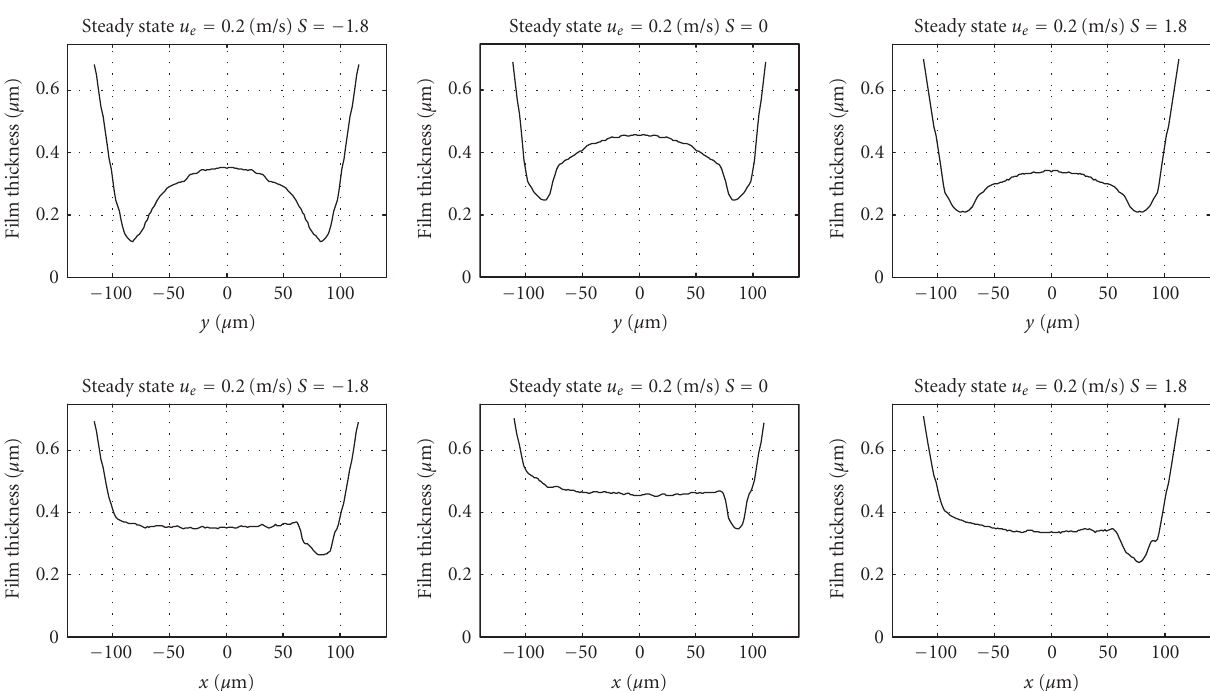
Figure 13: Film thickness profiles along the y - (top) and x -directions (bottom) (perpendicular to the entraining direction and entraining direction, resp.) under steady-state conditions for S = − 1.8, S = 0, and S =